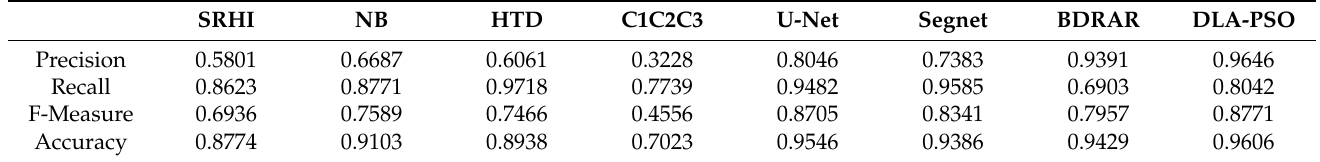
Table 2. Austin shadow-test-evaluation index.